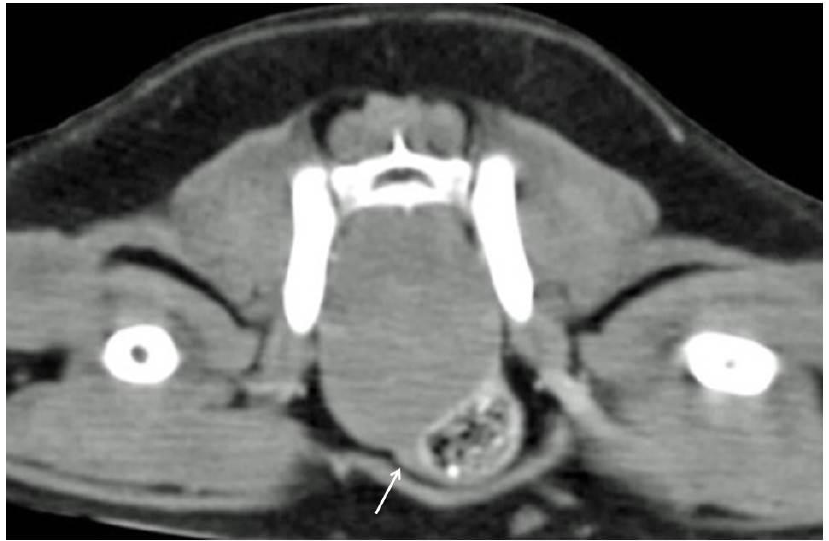
Figure 1. Tomographic appearance of a intra-pelvic mass. The colon is displaced ventrolaterally. The urethra is highlighted by the white arrow.